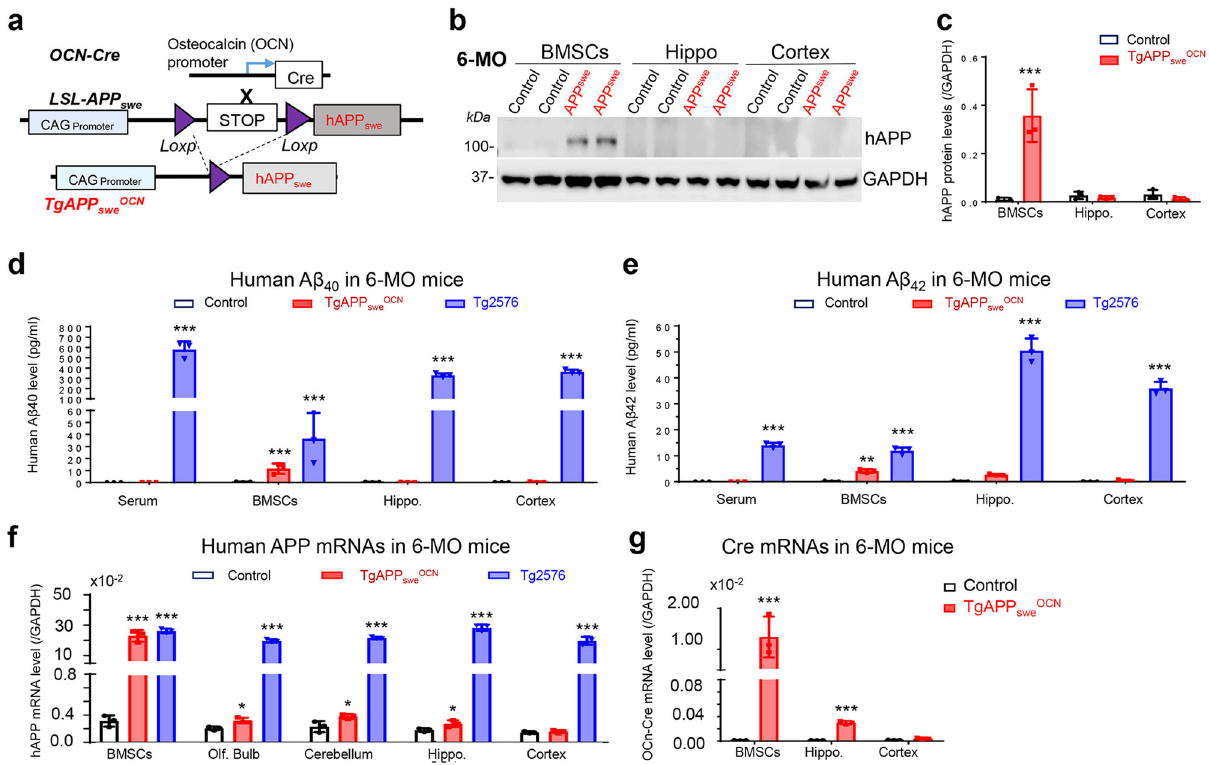
Fig. 1 Speci fi c expression of APP swe in OB-lineage cells in TgAPP swe OCN mice. a Illustration of the transgene and generation of the conditional transgenic mice selectively expressing human APP swe in an OCN-Cre dependent manner. b , c Western blot analysis of human APP (hAPP) protein levels in BMSCs, hippocampus, and cortex of 6-MO control ( LSL-APP swe ) and TgAPP swe OCN mice. b Representative blots; and c quanti fi cation. d , e ELISA analyses of human A β 40 ( d ) and A β 42 ( e ) levels in serum, BMSCs (50 μ g in total protein), and brain homogenates including hippocampus and cortex (300 μ g total protein) from 6-MO control, TgAPP swe OCN , and Tg2576 mice. f RT-PCR analysis of hAPP gene expression in BMSCs, olfactory bulb, cerebellum, hippocampus, and cortex of 6-MO control and TgAPP swe OCN mice. g RT-PCR analysis of Cre expression in BMSCs, hippocampus, and cortex of 6-MO control ( LSL-APP swe ) and TgAPP swe OCN mice. All data were presented as mean ± SD. * p < 0.05, ** p < 0.01, *** p < 0.001 ( n = 3 mice). Mann – Whitney U test was used in c and g , and one-way ANOVA followed by Tukey post hoc test was used in d – f